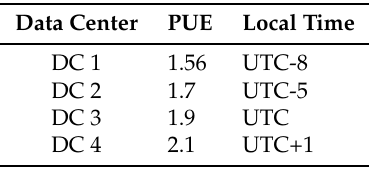
Table 1. Power usage effectiveness (PUE) and local time of the four DCs in the examined